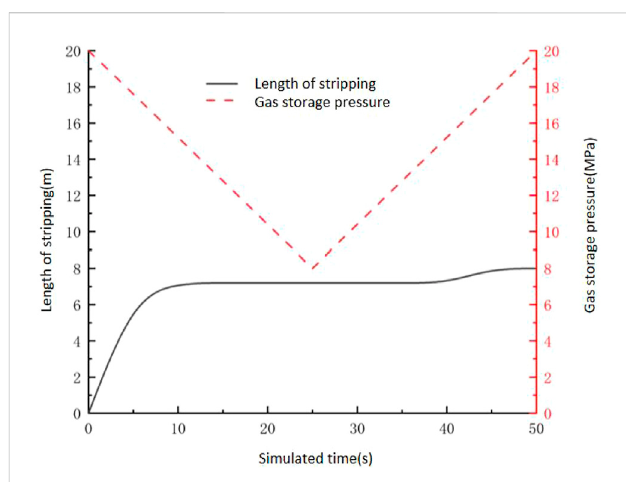
FIGURE 8 Stripping failure length vs.